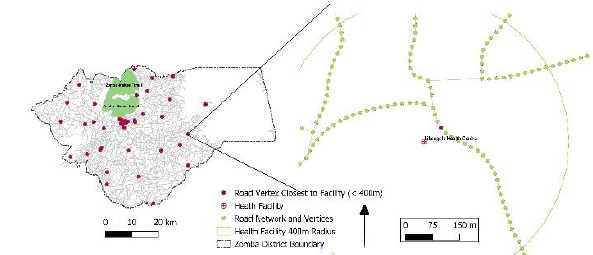
Figure 3 Road vertex closest to Likangala Health Centre The network travel cost from a facility to every vertex on the road network, calculated from the vertex closest to the facility, averaged with a minimum of and maximum of . Factoring in the slope, the travel cost averaged with a minimum of and maximum of . Figure 4 shows the network travel cost compared against the straight-line distances for each of the facilities.